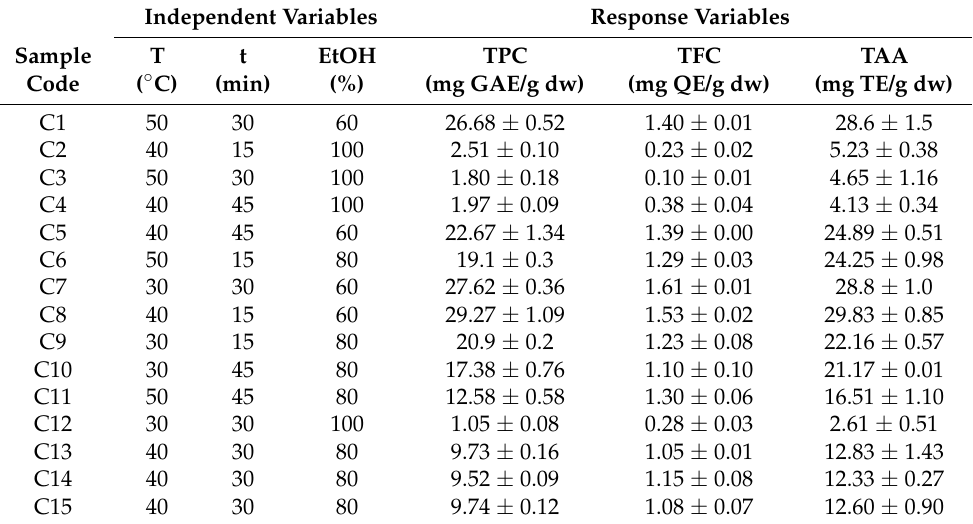
Table 1. Box-Behnken experimental design (BBD) with independent variables and experimental values for the responses of TPC, TFC, and TAA from cornelian cherry extracts obtained by conven- tional